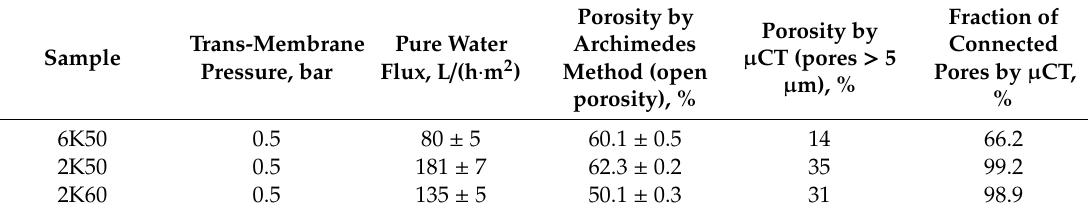
Test conditions and results of water permeation analysis for freeze cast cement membrane